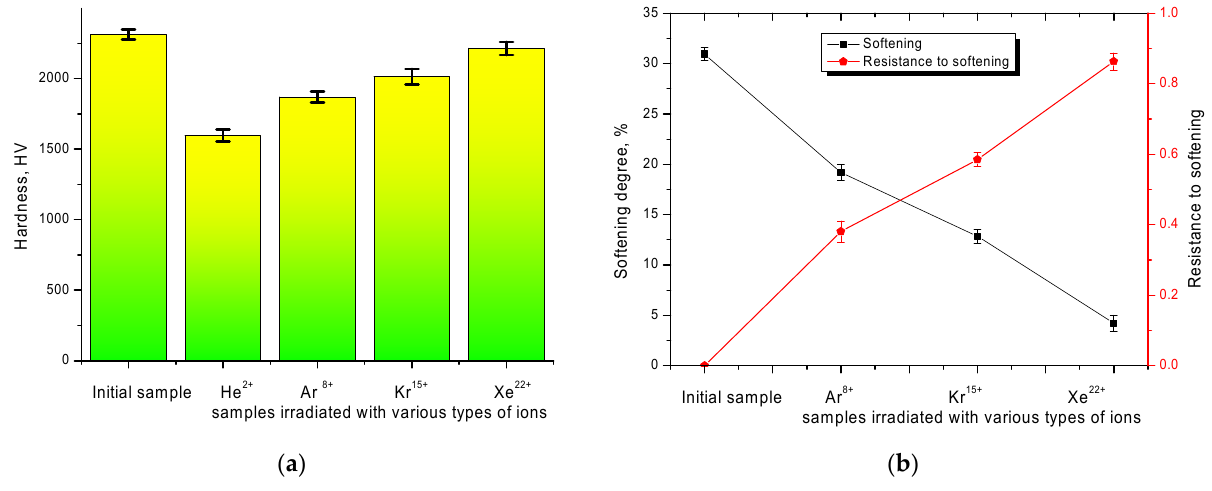
Figure 4. ( a ) Results of changes in ceramic hardness after irradiation with He 2+ ions. ( b ) Results of near-surface layer softening degree and softening resistance change.